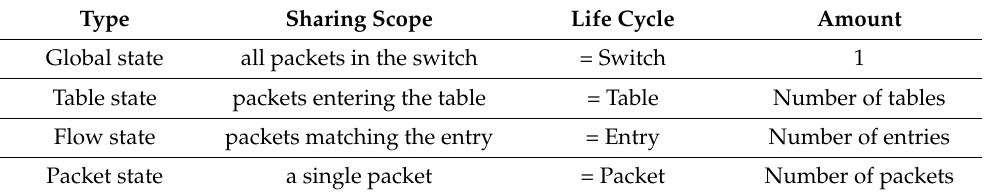
Table 2. Four types of states’ sharing scope, life cycle, and quantity in the switch.